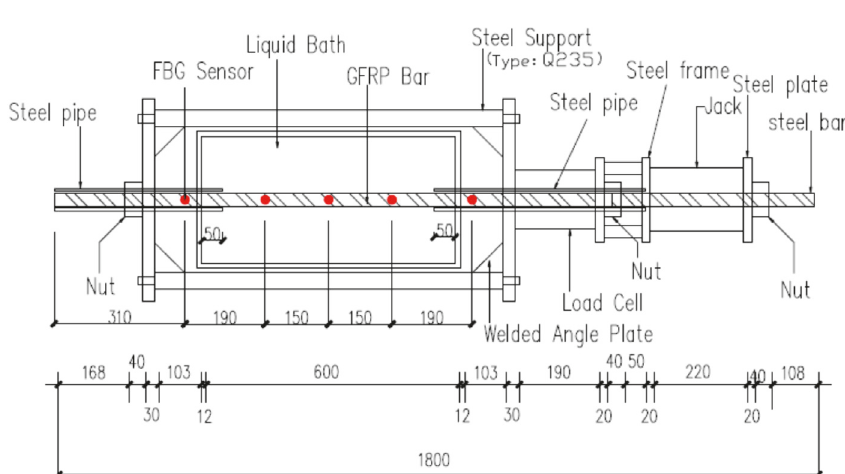
Figure 4: Detailed diagram of experimental setup.